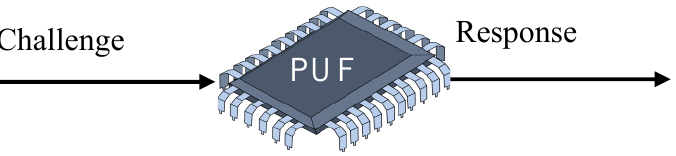
Figure 4. Challenge–Response